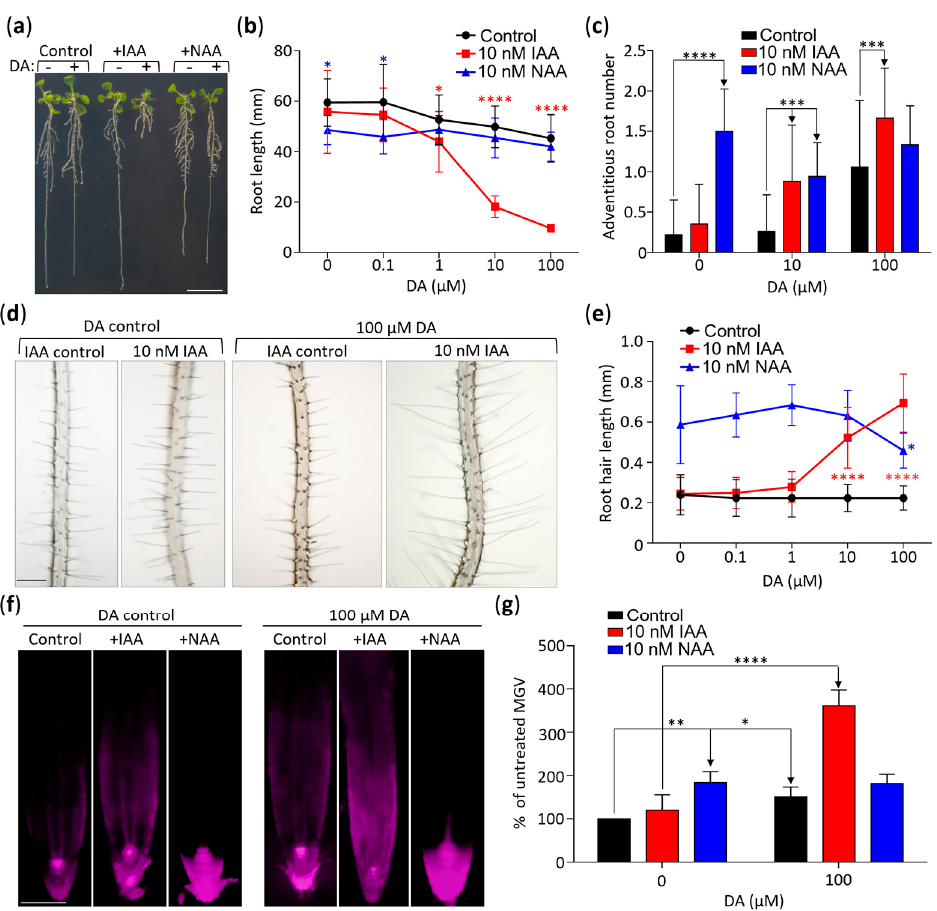
Figure 4. DA-dependent hypersensitization of IAA responses is linked to auxin influx. ( a ) DA exposure causes hypersensitivity to IAA but not to NAA. Representative Col-0 seedlings grown vertically for 14 days on media, were transferred to a fresh plate, and were photographed. Scale: 10 mm. ( b ) Quantitative analysis of the combinational impact of DA, IAA, and NAA on primary root length. Plants were grown as described in ( a ) and were photographed, and primary root length was measured using ImageJ software. Data are presented as mean ± SD ( n ≥ 12; * represents p < 0.05; **** represents p < 0.0001; two-way ANOVA with Tukey’s post-test comparing the control with hormone treatments; significance markers are color-coded by treatment to highlight comparisons to control). ( c ) Quantitative analysis of the combinational impact of DA, IAA, and NAA on the number of adventitious roots. Adventitious roots of plants grown as in ( a ) were counted using a microscope. Data are presented as mean ± SD ( n ≥ 16; *** represents p < 0.001; **** represents p < 0.0001; two-way ANOVA with Tukey’s post-test; multiple comparisons are denoted by one-way arrows). ( d ) DA and IAA co-treatment increases root hair length. Micrographs of plants grown as in ( a ) were taken at 4 × magnification. Scale: 100 µ m. ( e ) Graph illustrating DA’s effect on IAA-induced increase in root hair length. Root hairs were imaged as in ( d ), and their length was measured using ImageJ software. Data are presented as mean ± SD ( n ≥ 100; * represents p < 0.05; **** represents p < 0.0001; Tukey’s post-test comparing control with hormone treatments; significance markers are color-coded by treatment to highlight comparisons to control). ( f ) DR5::RFP expression confirms that DA induces hypersensitivity to IAA but not to NAA. DR5::RFP seedlings were grown for 7 days at the denoted concentrations of DA, IAA, and NAA, and RFP fluorescence was captured using fluorescent microscopy. Scale: 100 µ m. ( g ) Quantitative analysis of DR5::RFP signal shown in ( f ). Root tissue was traced 600 µ m basipetally from the root cap, and mean grey value (MGV) was calculated using ImageJ software. Data are presented as percent of the control MGV ± SEM ( n ≥ 12; **** represents p < 0.0001; ** represents p < 0.01; * represents p < 0.05; two-way ANOVA with Tukey’s post-test; multiple comparisons are marked with one-way